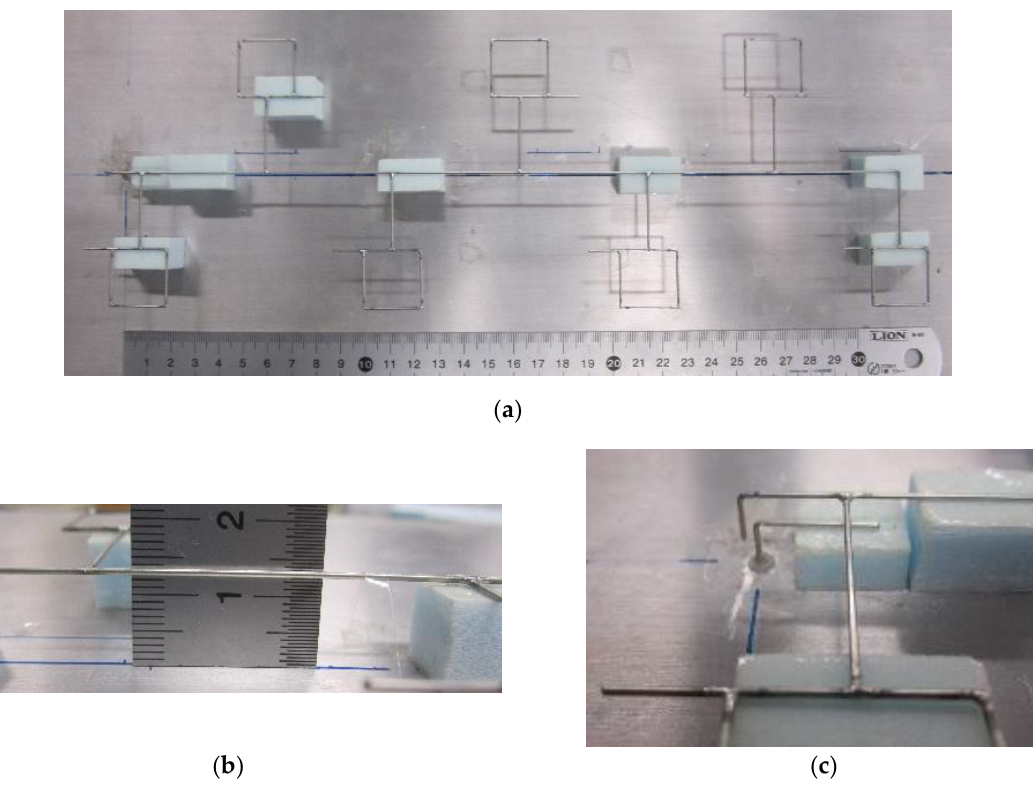
Figure 10. Prototype of a modified branched line antenna with N = 4: ( a ) top view; ( b ) side view; ( c ) perspective view of an electromagnetic-coupling feed.